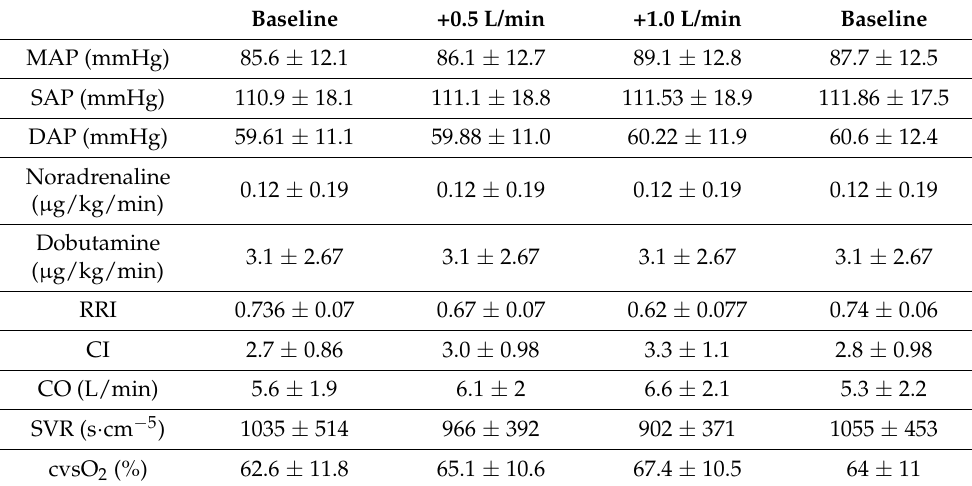
Table 2. Parameters of invasive hemodynamic measurement on different levels of Impella ® sup- port. MAP: mean arterial pressure; SAP: systolic arterial pressure; DAP: diastolic arterial pressure; RRI: renal resistive index; CI: cardiac index; CO: cardiac output; SVR: systemic vascular resistance; cvsO 2 : central venous oxygen saturation.